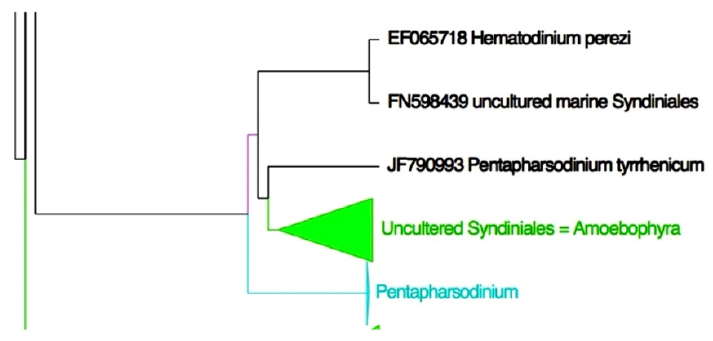
Figure 5. Enlarged view of Clade 2.